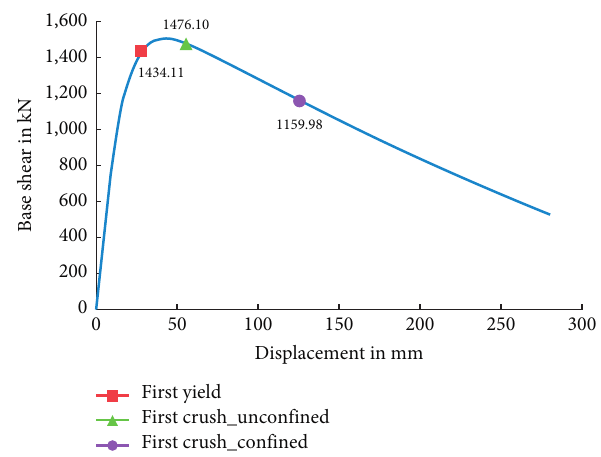
Figure 13: Damage pattern of open ground storey RC-infilled frame in X direction.